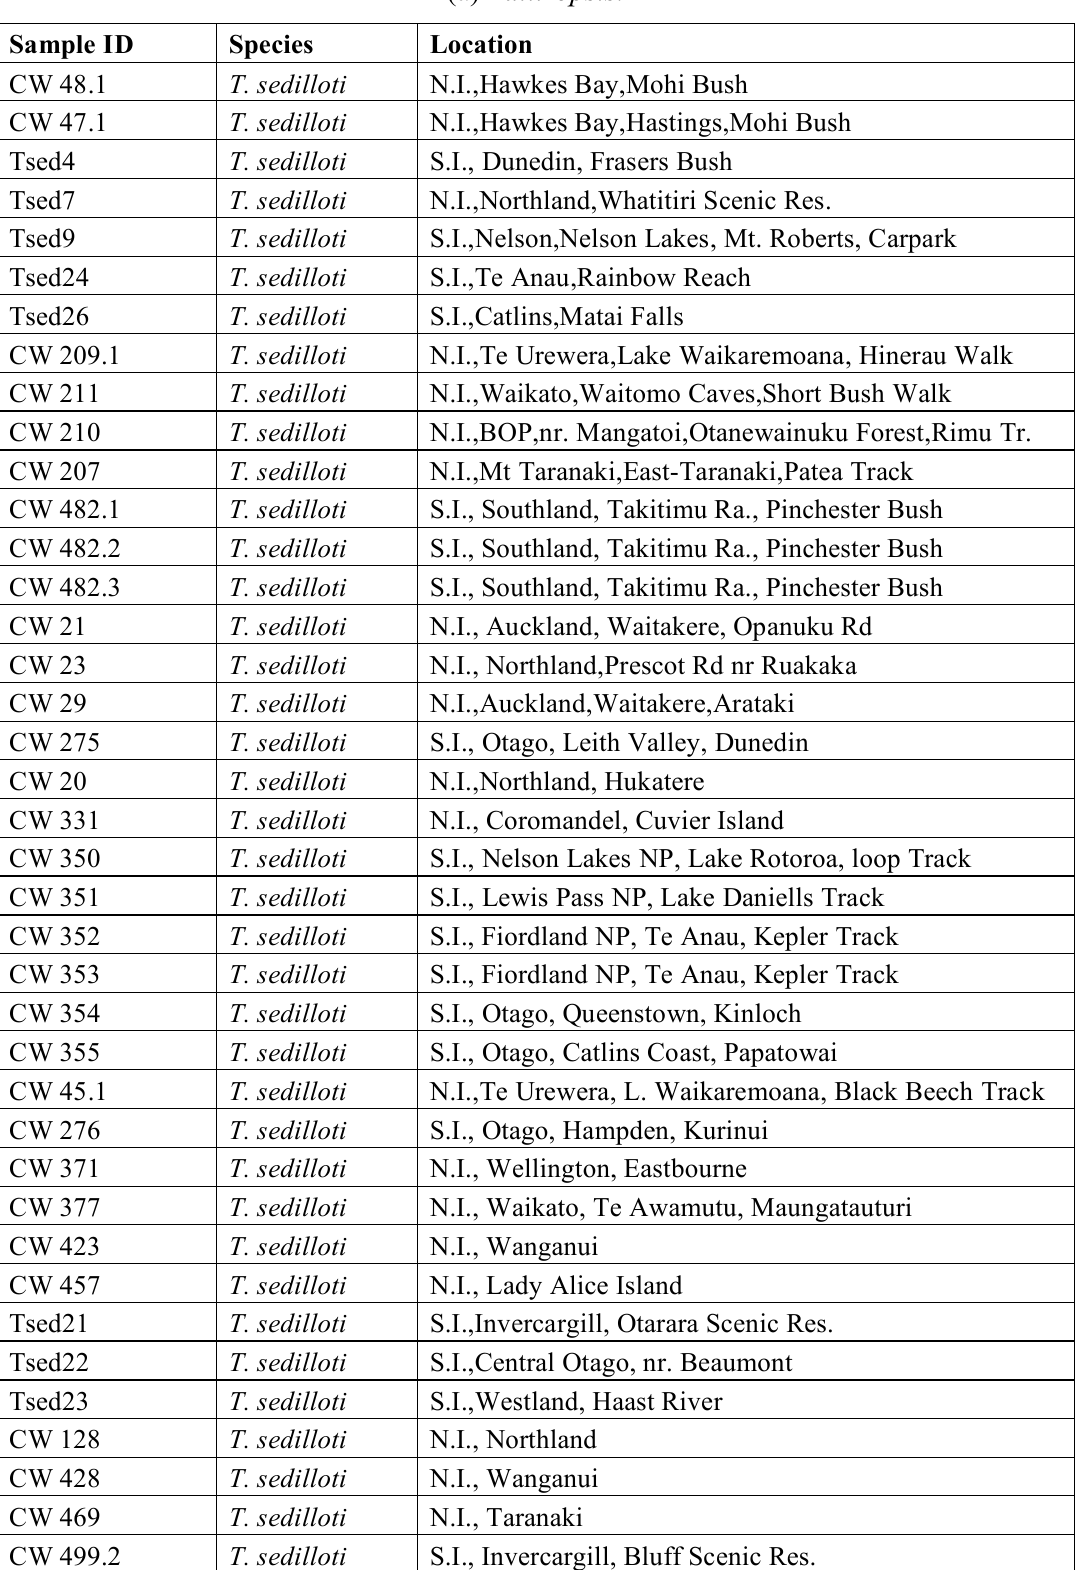
Table S1. Taxon samples used in this study with voucher numbers and sampling